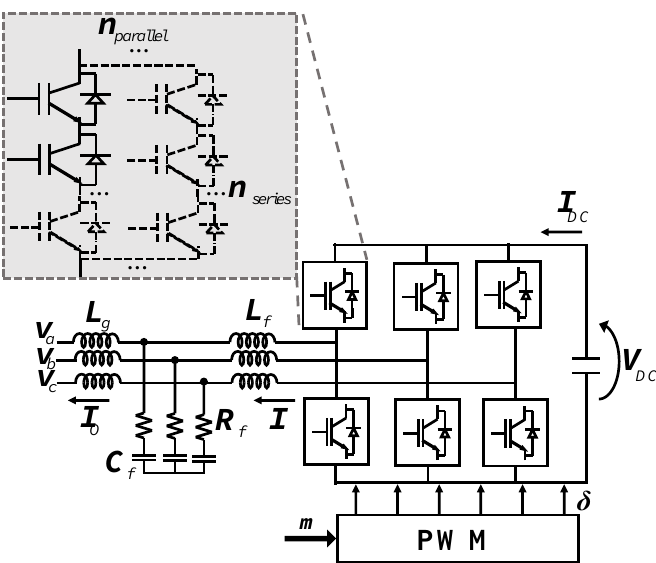
Figure 2. Power electronics structure of the shunt active power filter—SAPF